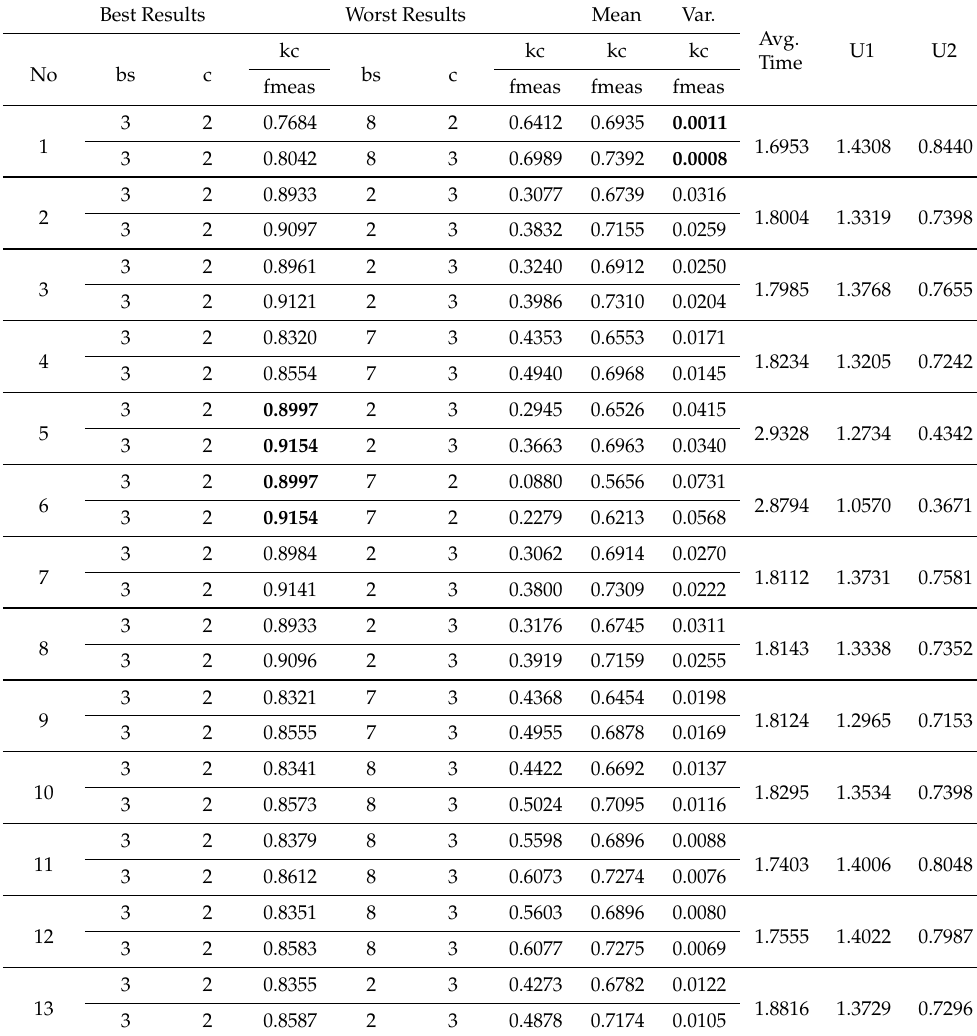
Table A1. Results of Ottawa